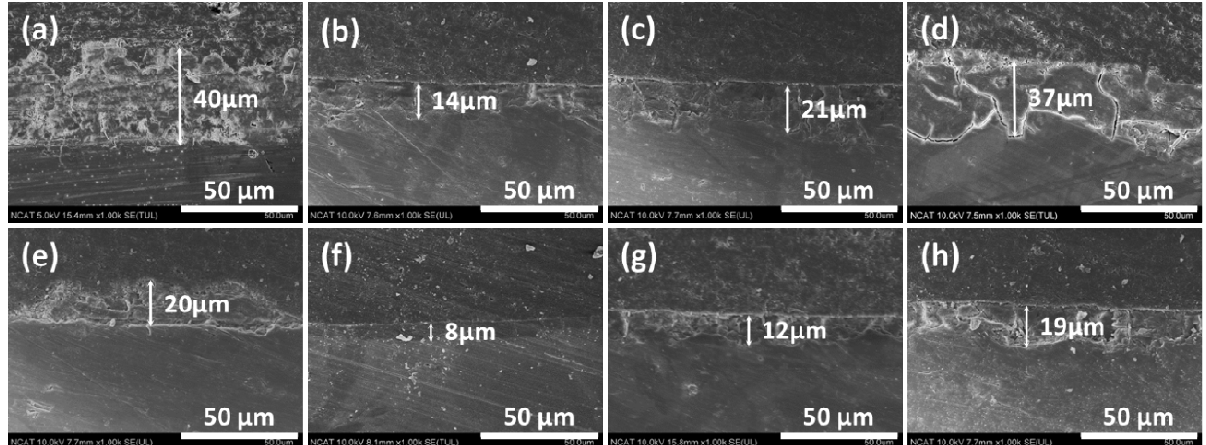
Figure 5. Thickness of corrosion products formed on the surface after immersion for 10 days in modified Gamble’s solutions: ( a ) Solution #1; ( b ) Solution #2; ( c ) Solution